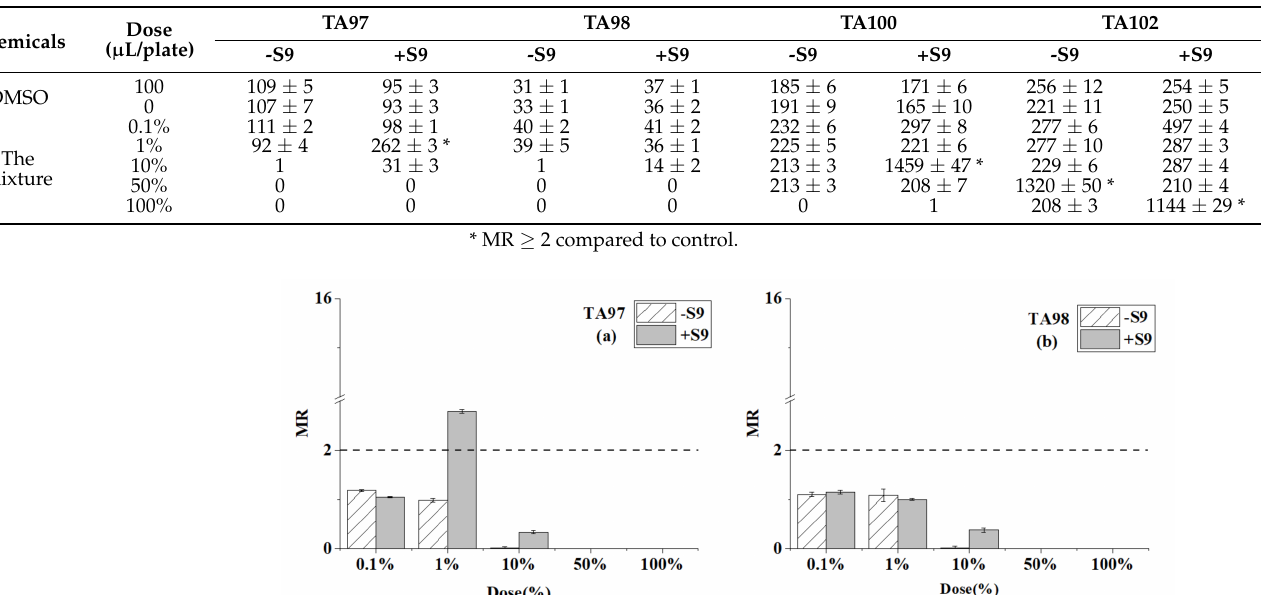
Table 4. Reverse mutation colonies of four S. typhimurium strains by the mixtures of toluene, chloroform, and trichloroethy- lene with and without S9.